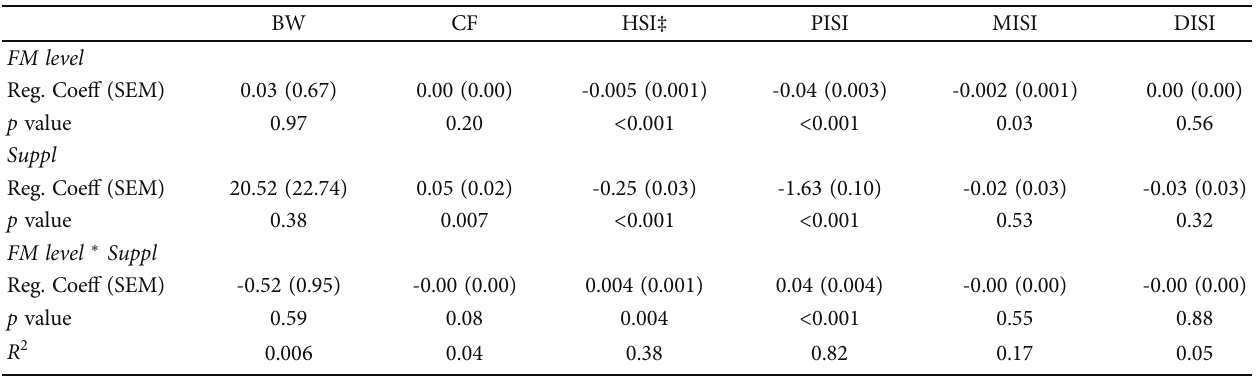
Table 3: Results for regression analyses for (BW), condition factor (CF), liver index (HSI), and intestinal section indices based on individual observations † .